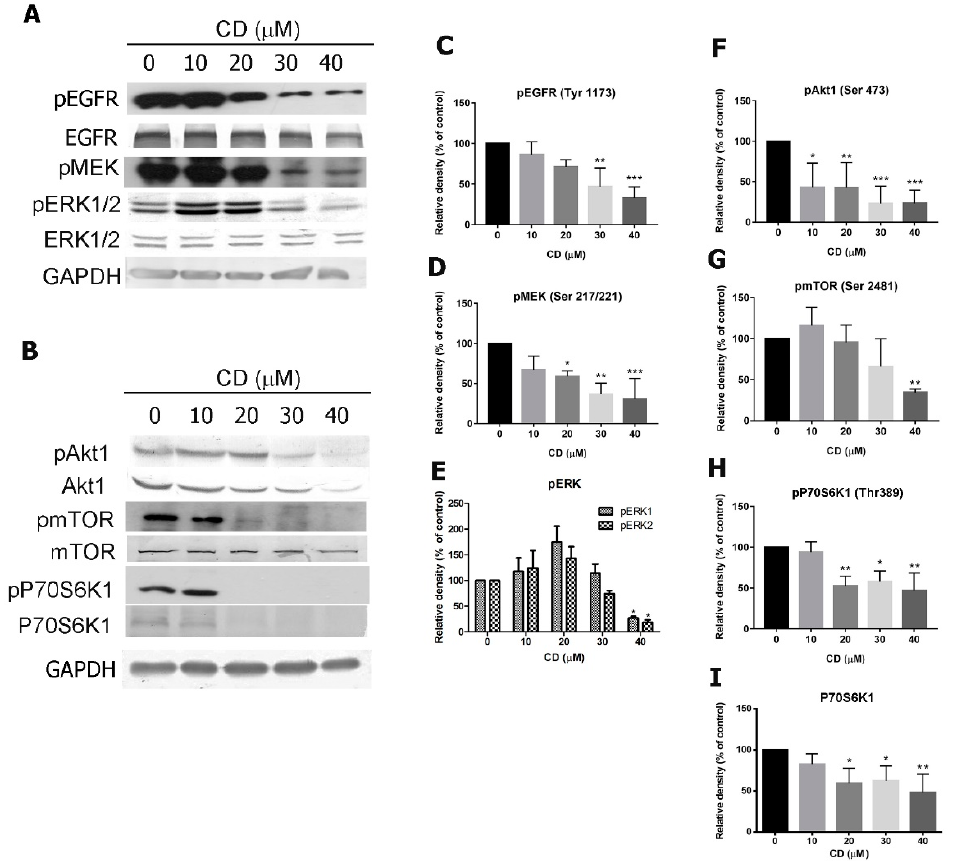
Figure 7. Effects of CD on oncogenic signal molecules. ( A ) The protein expression of pEGFR, EGFR, pMEK, pERK1/2, and ERK1/2. ( B ) The protein expression of pAkt1, Akt1, pmTOR, mTOR, pP70S6K1, and P70S6K1. GAPDH was used as an internal control. ( C )–( I ) Quantification results of each protein. Bar graphs show values normalized as percentages relative to the control. Data are expressed as mean ± SD of three to four independent experiments. * p < 0.05, ** p < 0.01, *** p < 0.001 as compared with the control group (0 µM).